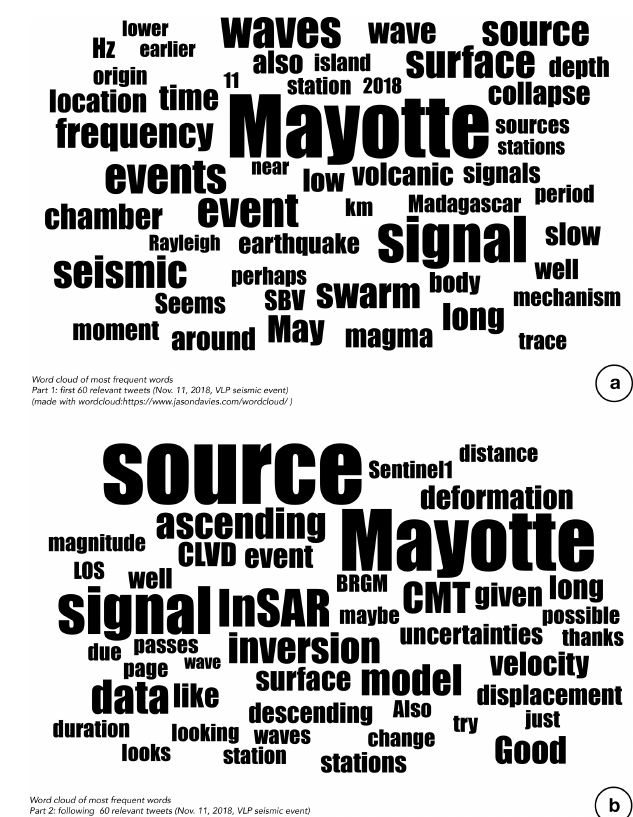
Figure 5. Word clouds illustrating the evolution of topics discussed on Twitter after the Mayotte 11 November 2018 very long-period (VLP) seismic event. The top word cloud (a) illustrates the first 60 tweets of the selected Twitter moment with most frequent words regarding the VLP signal (signal, event(s), wave(s), seismic, and frequency) and its geographic origin (Mayotte and location). The bottom word cloud (b) , which corresponds to the subsequent 60 tweets, shows a discussion more focussed on the geophysical source of the VLP event (source, signal, CMT, CLVD, and deformation) and data processing (data, model, InSAR, and